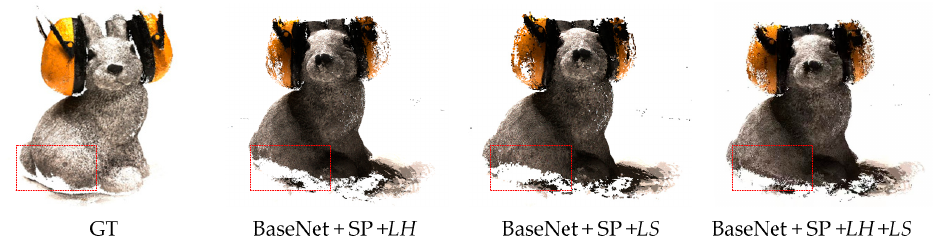
Figure 6. Comparison of effects after ablation.